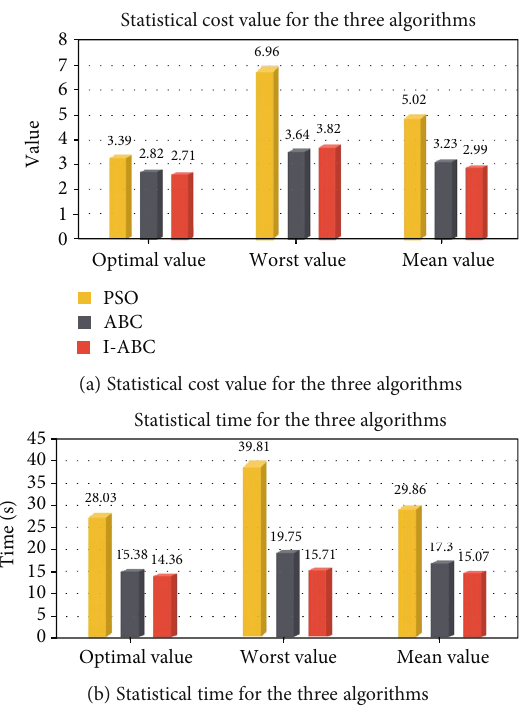
Figure 20: The statistical results for the three